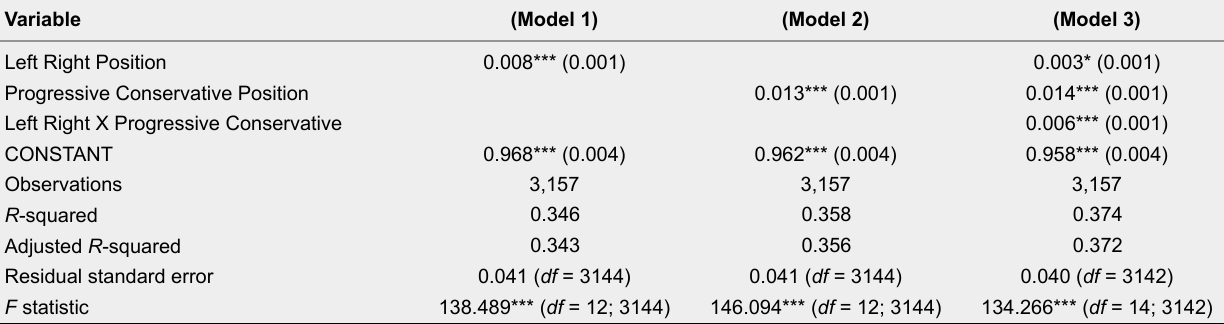
OLS Model of Proportion of Unique Words on Speaker Ideology